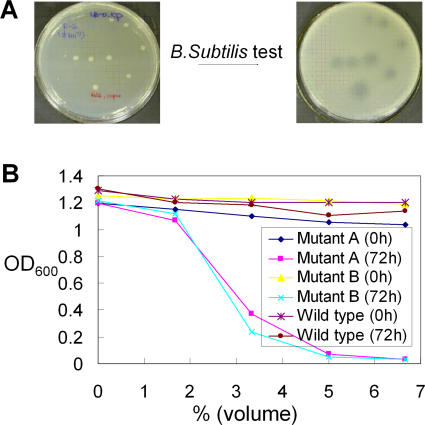
Screening for 6d-EryD Overproducers(A) Single-colony screening assay of the Mutant A: B. subtilis inhibition assay after 60 h.(B) Shake-flask production of 6d-EryD by mutants, as assayed via B. subtilis inhibition assay. Comparison of Mutant A versus Mutant B versus wild-type of strain BAP1/pBP130/pBP144/pHL80/pHL74 after 72 h. Cells were grown in the presence of 2 g/l propionate, and induced with 0.5 mM IPTG at 30 °C.